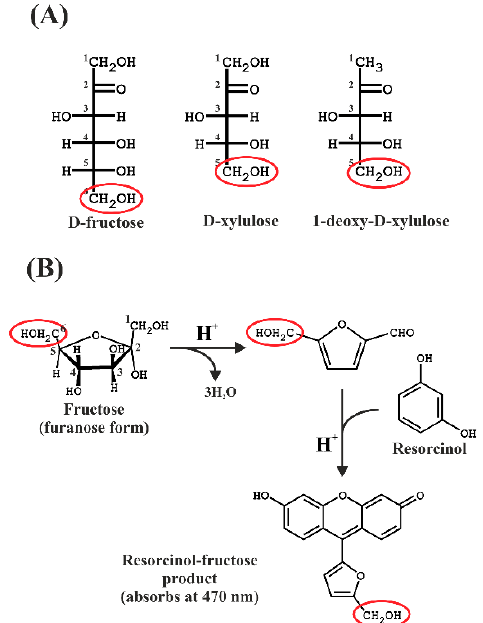
Figure 1. ( A ) Fisher projections of the sugars used in this study. The hydroxymethyl groups remaining after the furfural formation are indicated by red ellipses. ( B ) Reaction scheme showing the formation of the furfural intermediate, which then reacts with resorcinol in the presence of hot concentrated acid.